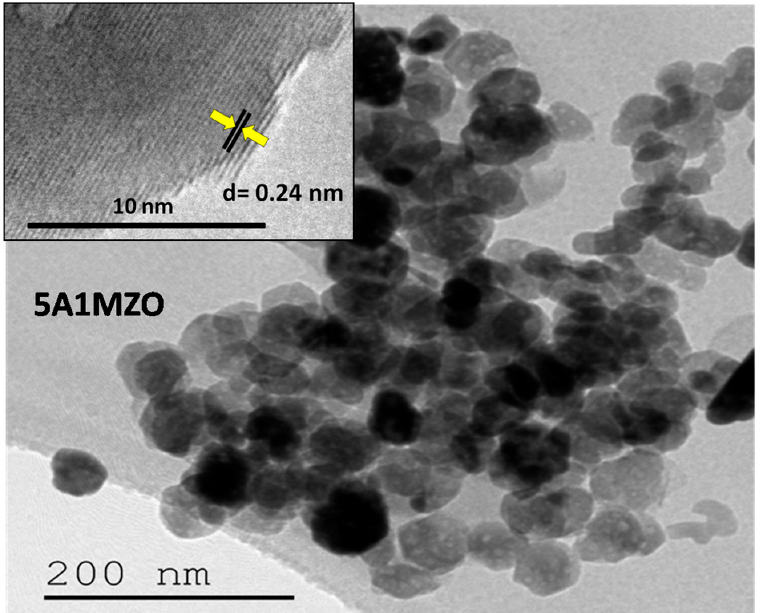
Figure 7. TEM image of 5A1MZO nanoparticles at 200 nm. The inset presents the HRTEM image at 10 nm.